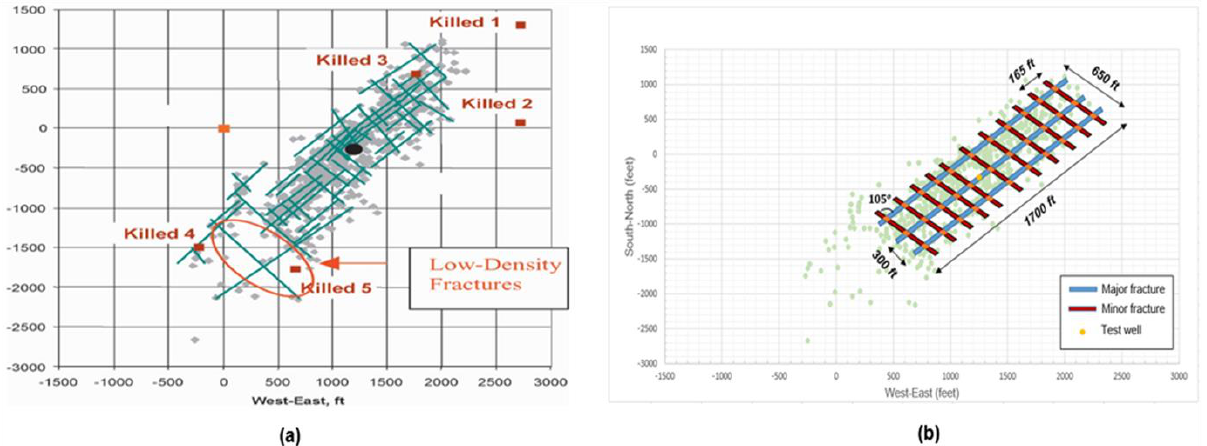
Figure 24. ( a ) Complex-fracture network interpretation for Barnett shale microseismic image recorded during fracturing (Fisher et al. [36], permission of SPE); ( b ) a simplified fracture network in the BEM model (after Fisher et al. 2002).